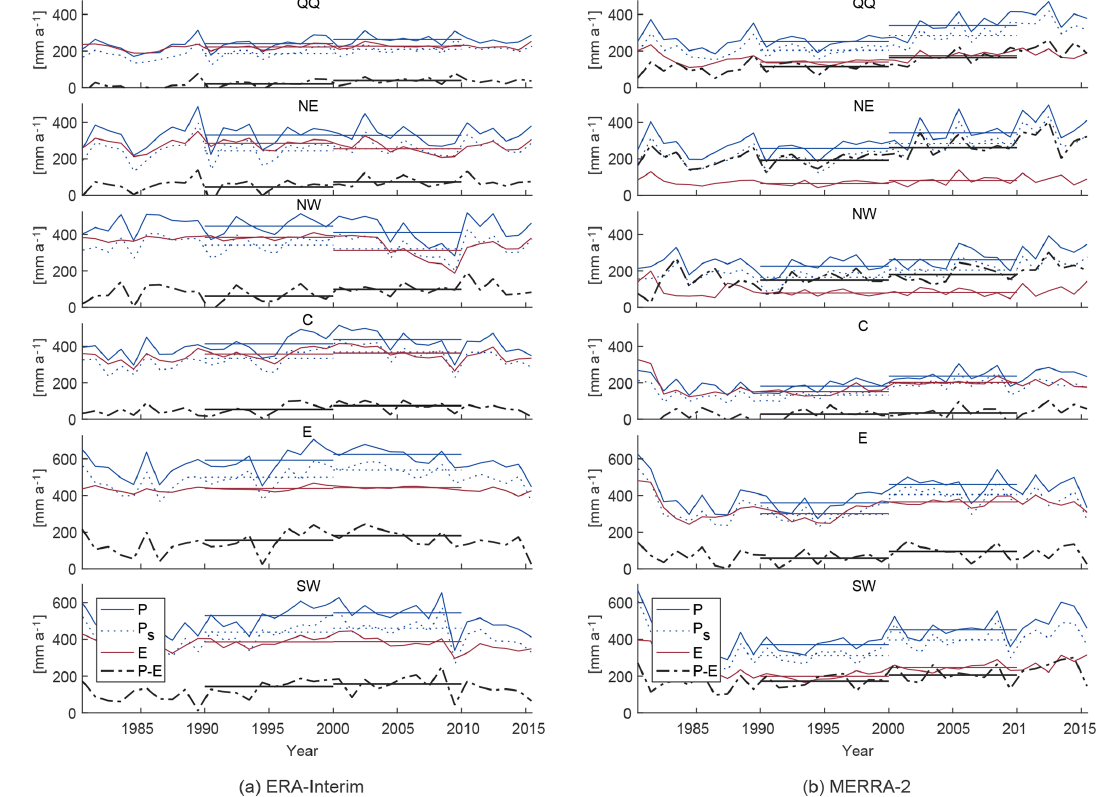
Figure 7. Time series for (a) ERA-Interim and (b) MERRA-2 of annual total precipitation ( P ), evaporation ( E ), the difference between the two ( P − E ), summer precipitation ( P s , May–Sept) and their respective decadal averages, for reanalysis grid points within the six lake change regions on the TP: southwestern (SW), eastern (E), central (C), northwestern (NW), northeastern (NE) TP and Qaidam Basin/Qilian Shan (QQ). Table 1. Precipitation/lake water volume changes between decadal averages of the 1990s and the 2000s per basin region (dP and dV), and annual glacier mass balance of adjacent glacierised areas for 2003–2008 (last column). dV: total decadal lake water volume difference in order in the southwestern TP: Shiquanhe, Gaize, Pulan, Nielaer. Glacier surface elevation changes are converted to mmw.eq.a − 1 assuming a density of 850kgm − 3